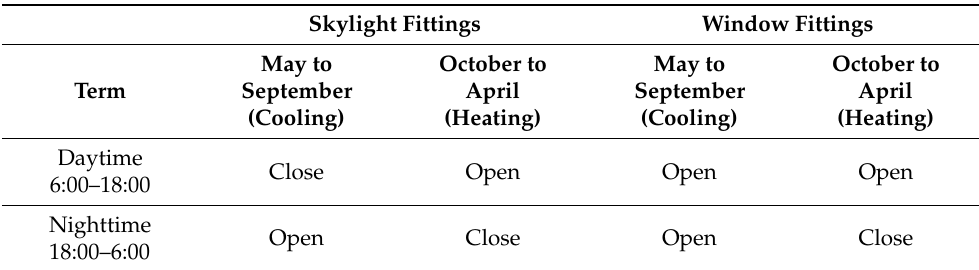
Table 5. Condition of fittings in the cases air-conditioned.